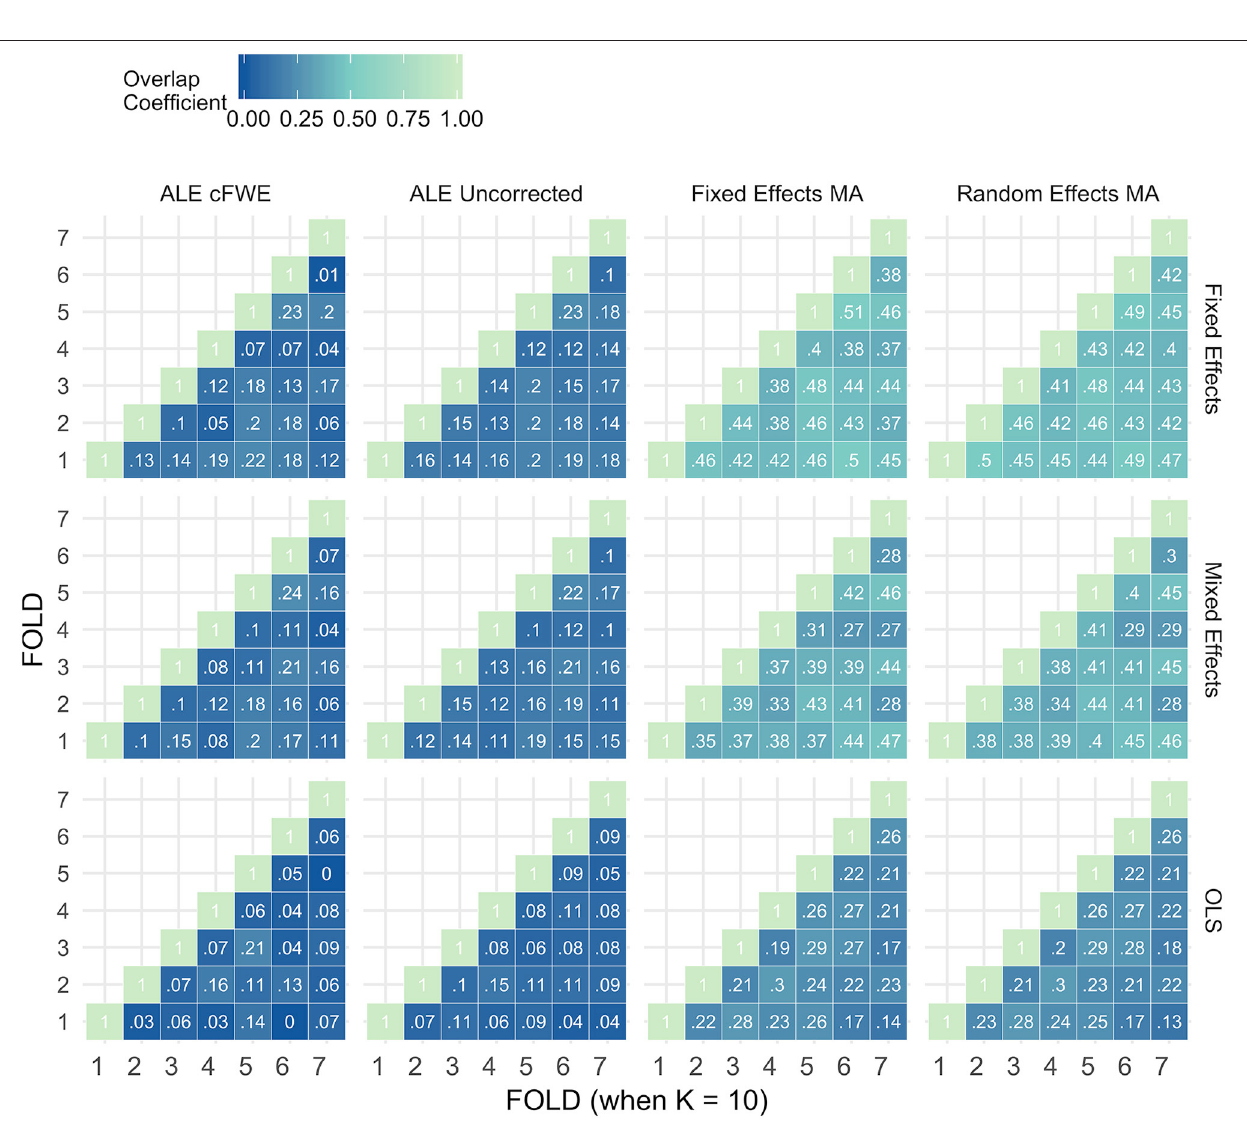
10. The rows represent the group level models (top to bottom: fixed effects, =